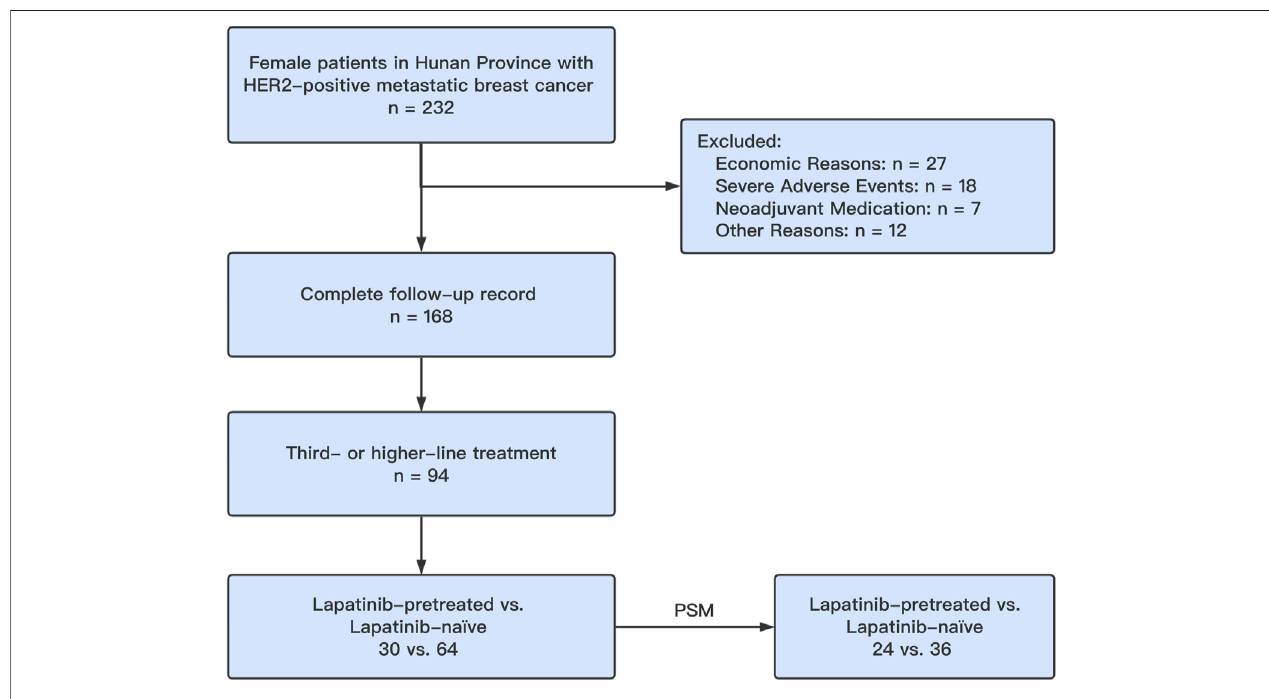
FIGURE 1 | CONSORT diagram for patient selection for the study. PSM, propensity score matching.